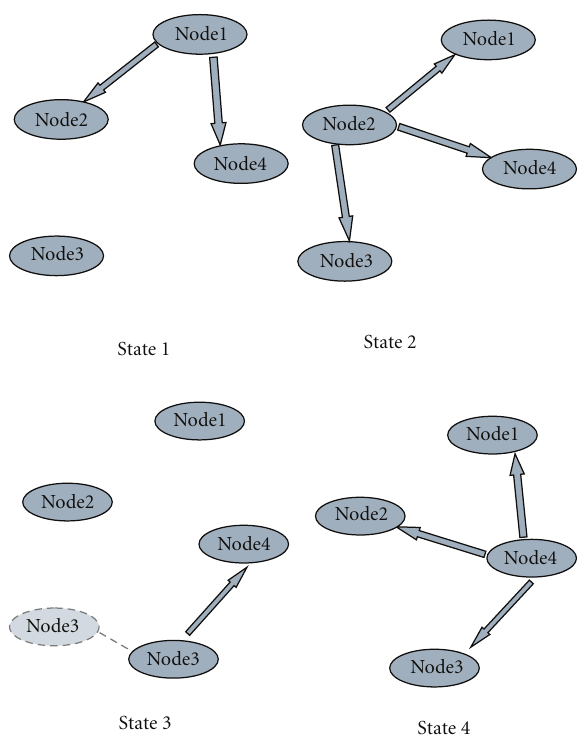
Figure 9: Data sharing process of the